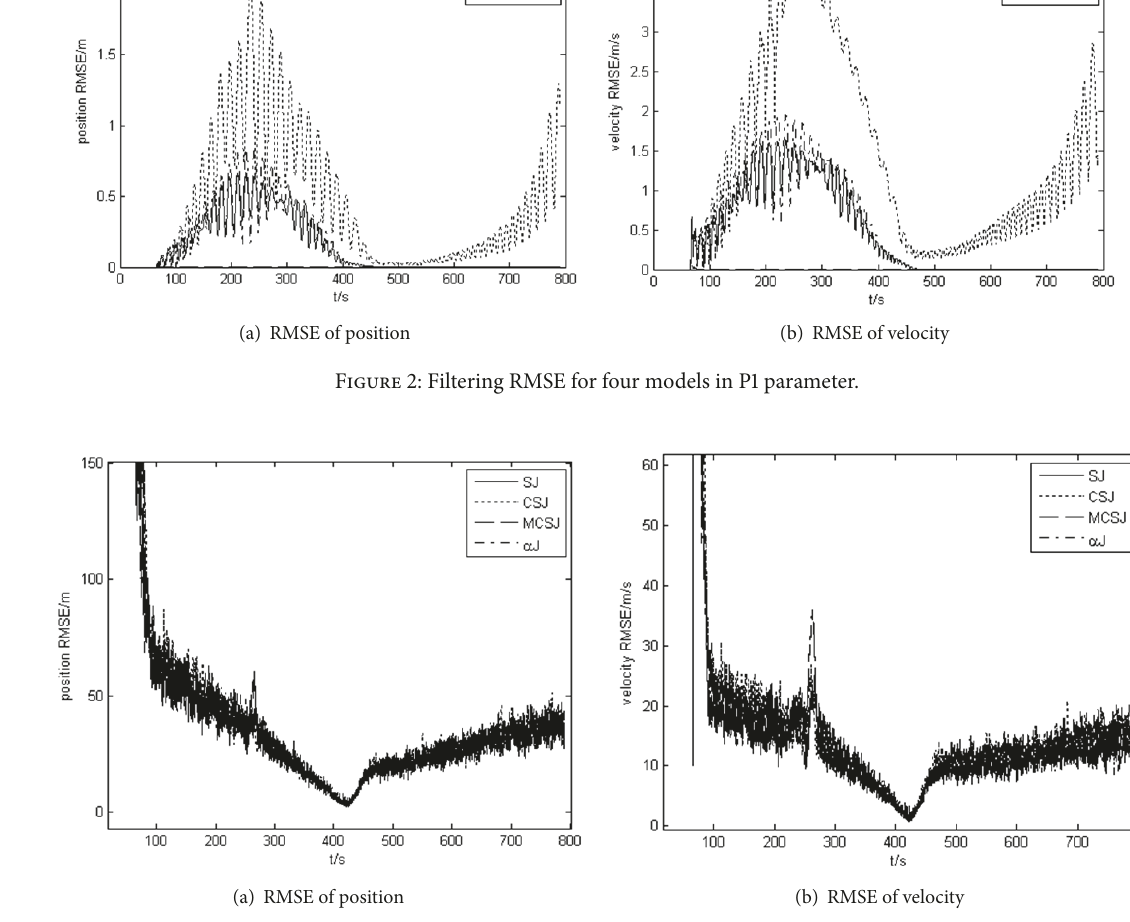
Figure 3: Filtering RMSE for four models in P2 parameter.